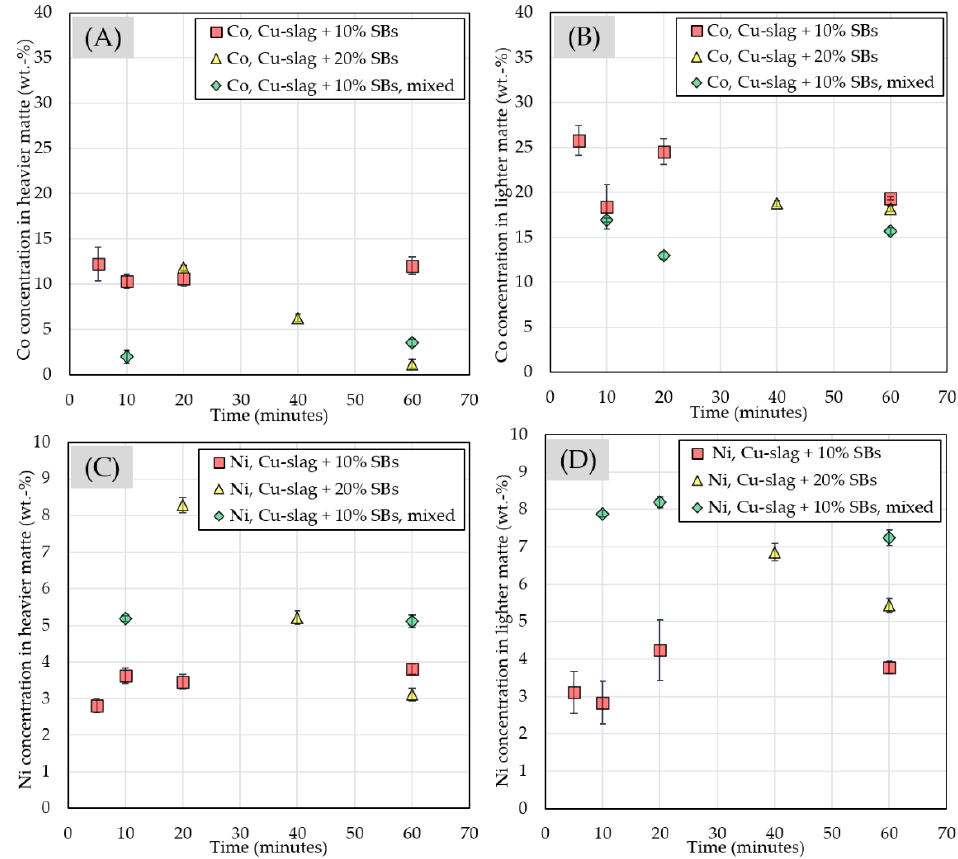
Figure 16. Concentrations of Co ( A , B ) and Ni ( C , D ) in heavier ( A , C ) and lighter ( B , D ) matte phase as the function of contact time.